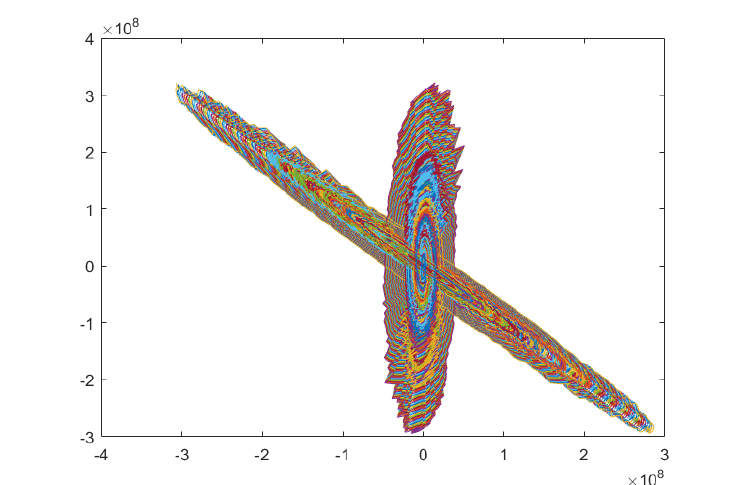
Figure 5. Phase plane of open-loop systems with 100 different initial conditions ( x 1 ∈ [ − 200,200 ] , x 2 ∈ [ − 200,200 ]